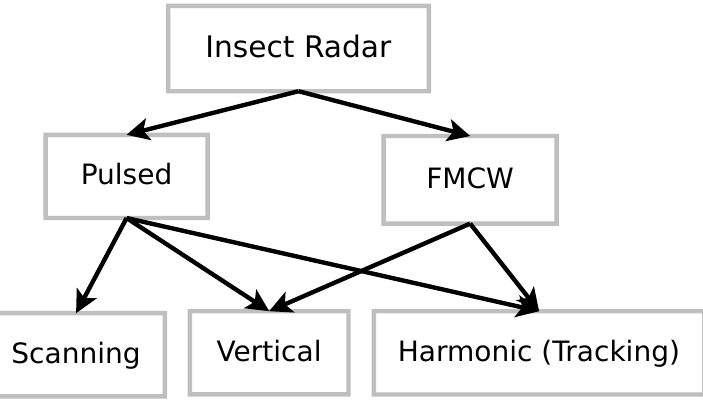
Figure 4. Insect radar groups.